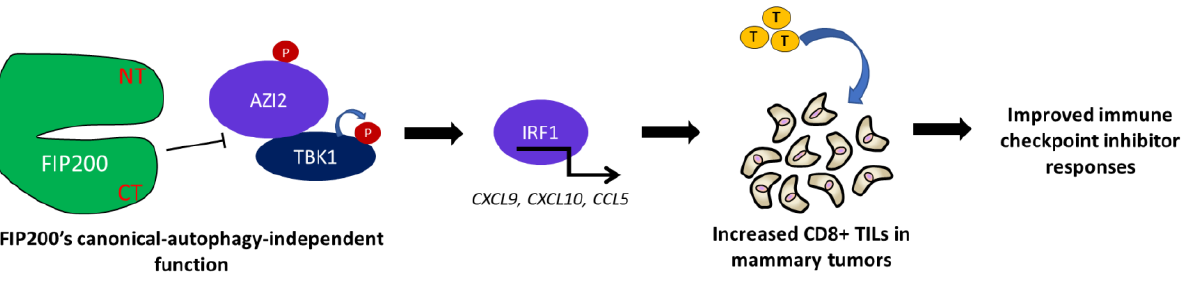
FIGURE 1: The canonical-autophagy-independent function of FIP200 regulates TBK1 activation, chemokine production, T-cell infiltration and immune checkpoint inhibitor efficacy. Schematic summarizing the phenotypes observed upon the loss of FIP200’s canonical - autophagy-independent function and a working model of this regulatory